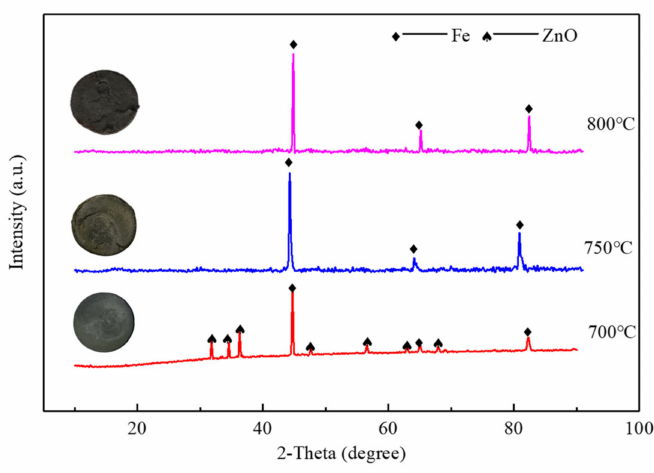
Figure 12. XRD patterns of cathode products at different electrolysis temperatures ( E = 1.8 V, t = 8 h).